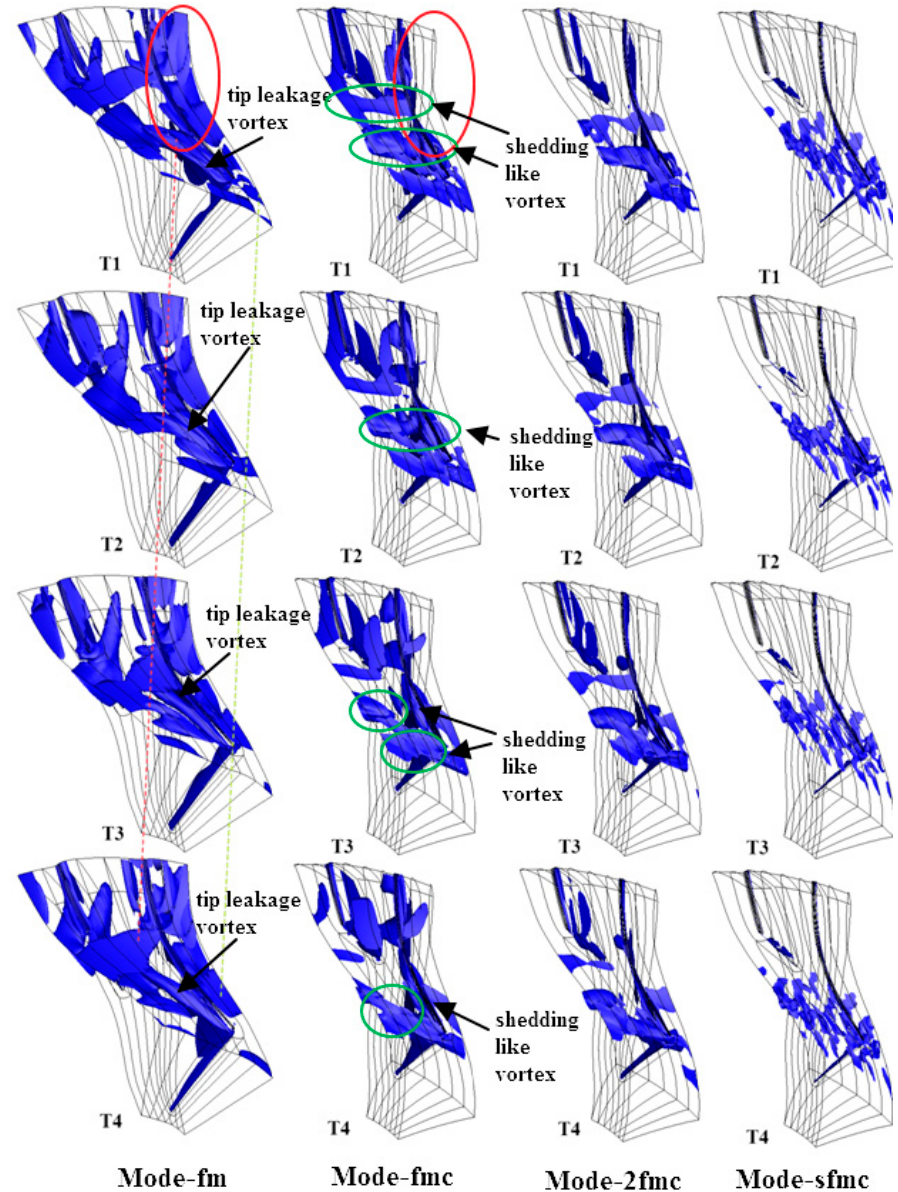
Figure 8. Dominant structure comparison of controlled and uncontrolled compressors.